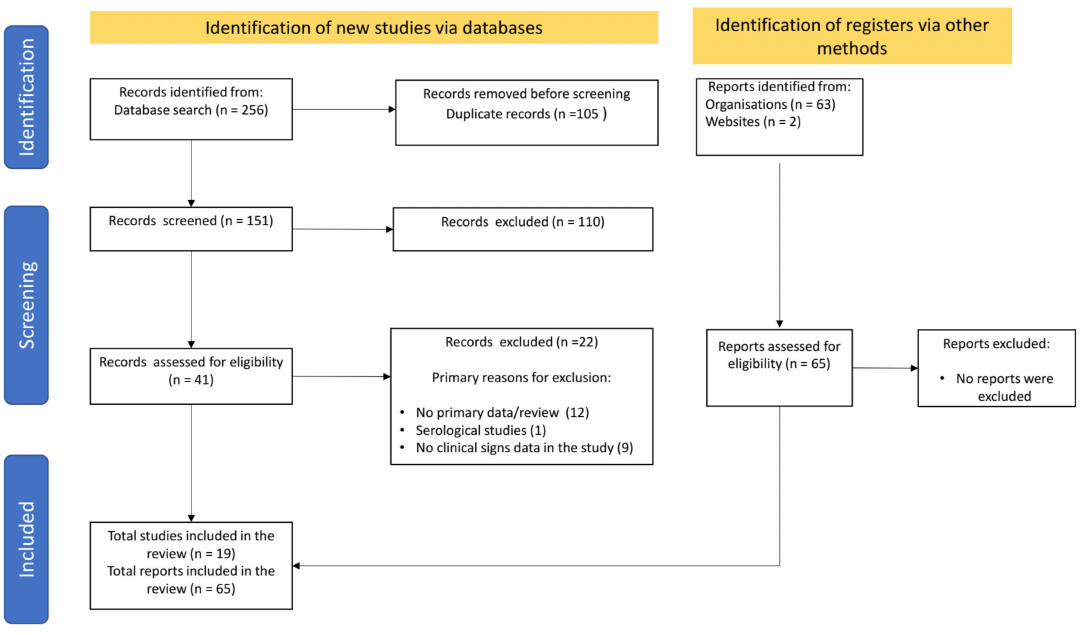
Figure 1. PRISMA workflow of search and selection of